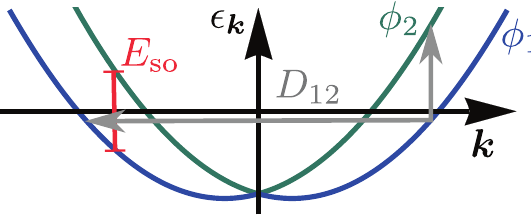
Fig. 4 Due to assumption ( i ), the inter-Fermi surface matrix elements ( gray arrow ) can be neglected as they couple